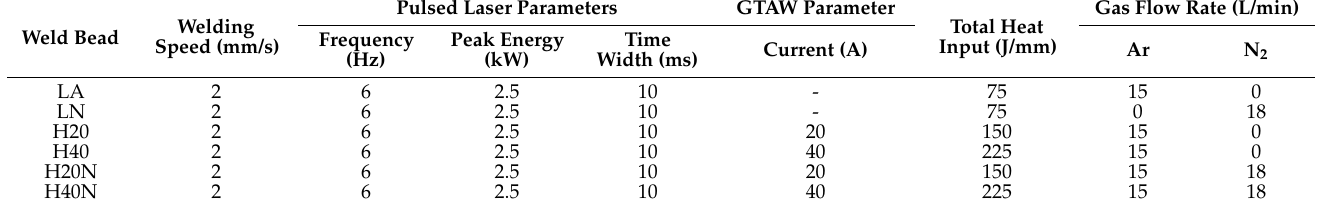
Table 2. Welding parameters.